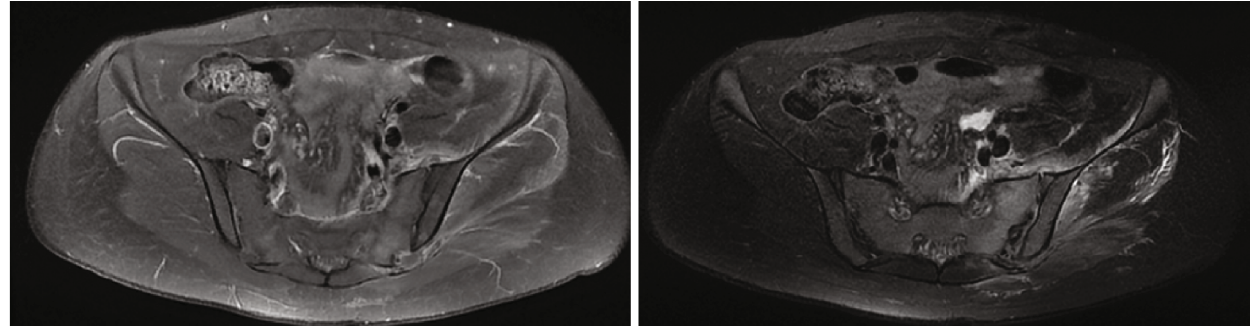
Figure 1: MRI of the pelvis: T1-enhanced and T2 axial views showing signal abnormality of the left sacroiliac joint, predominant in the sacral wing, characterized by hyperintensity on T2. There are signi fi cant signal abnormalities and gadolinium uptake of the musculature adjacent to the left sacroiliac joint. Anterior e ff usion of the left sacroiliac joint is visible with additional bulging of the posterior articular